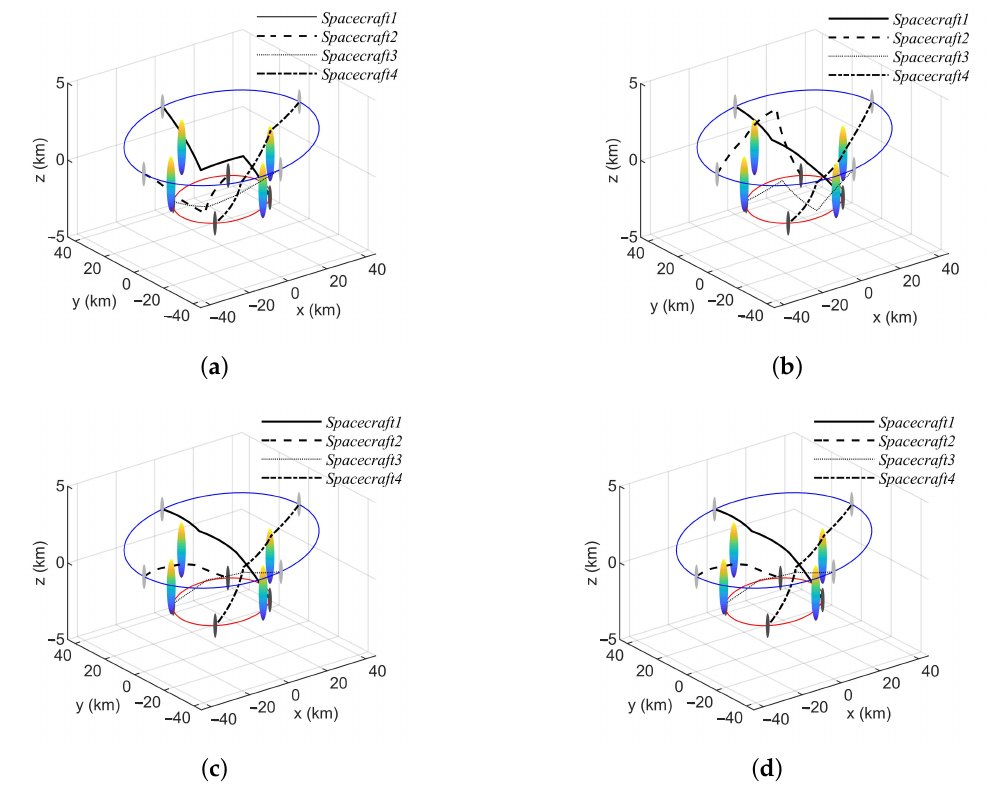
Figure 11. ( a ) PSO planning path, ( b ) PIO planning path, ( c ) CGAPIO planning path, ( d ) ALPIO planning path.